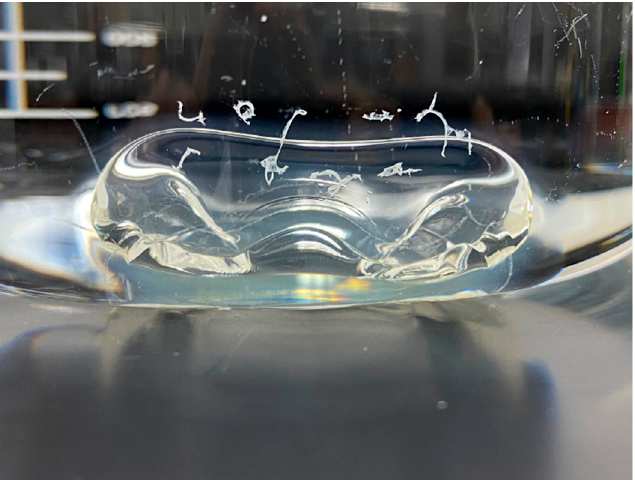
Figure 10. Pellicle formation due to cross-linking of SGC during a rupture test. Table 4. Examples of cross-linking of gelatin due to chemicals.